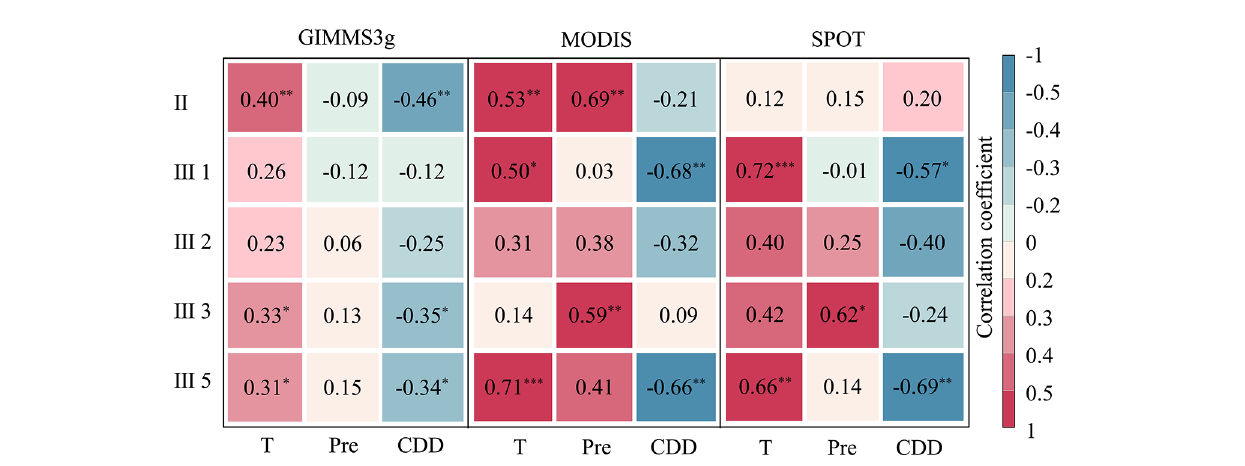
FIGURE 7 | Correlation coef fi cients between the vegetation DOD of GIMMS3g (1982 – 2012), SPOT (2000 – 2012), and MODIS (2000 – 2012) NDVI data sets and mean temperature (T), precipitation (Pre), and cold degree days (CDD) for different biome types: forest and alpine meadow ecoregion (II), needle-leaved forest and alpine meadow ecoregion (III1), agriculture and pasture ecoregion (III2), alpine meadow ecoregion (III3), alpine steppe ecoregion (III5). ***, **, and * represent the signi fi cant correlation at the 0.01, 0.05, and 0.10 levels, respectively. Correlations with no asterisk indicate nonsigni fi cant (P >